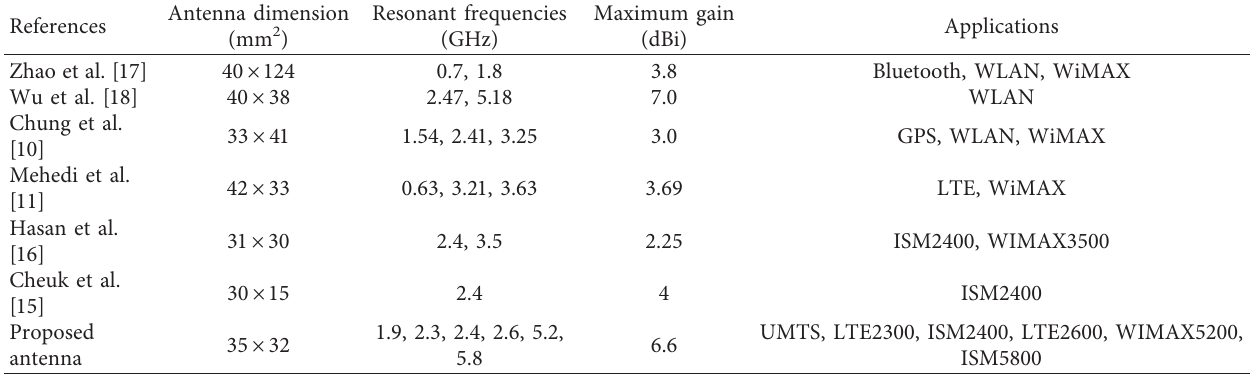
Figure 13: Influence of the smartwatch on the antenna S Table 3: Performance comparison between the proposed antennas with the existing antennas.